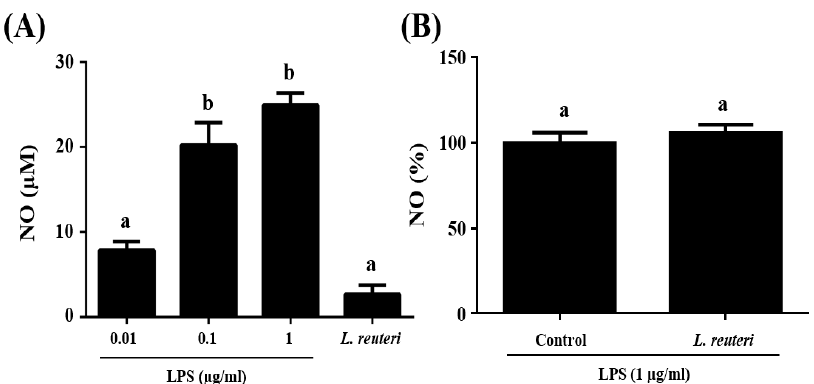
Figure 1. Data represent the mean ± standard deviation of at least three separate experiments. ( A ) NO production (µM) in a RAW 264.7 cell line upon stimulation with lipopolysacharides (LPS) (0.01, 0.1, and 1 µg/mL) or L. reuteri INIA P572. ( B ) Nitric Oxide (NO) production (%) of RAW 264.7 cells stimulated only with 1 µg/mL LPS (considered 100%) or previously activated with L. reuteri INIA P572. Different samples with different letters (a-c) show significant differences ( p < 0.05).